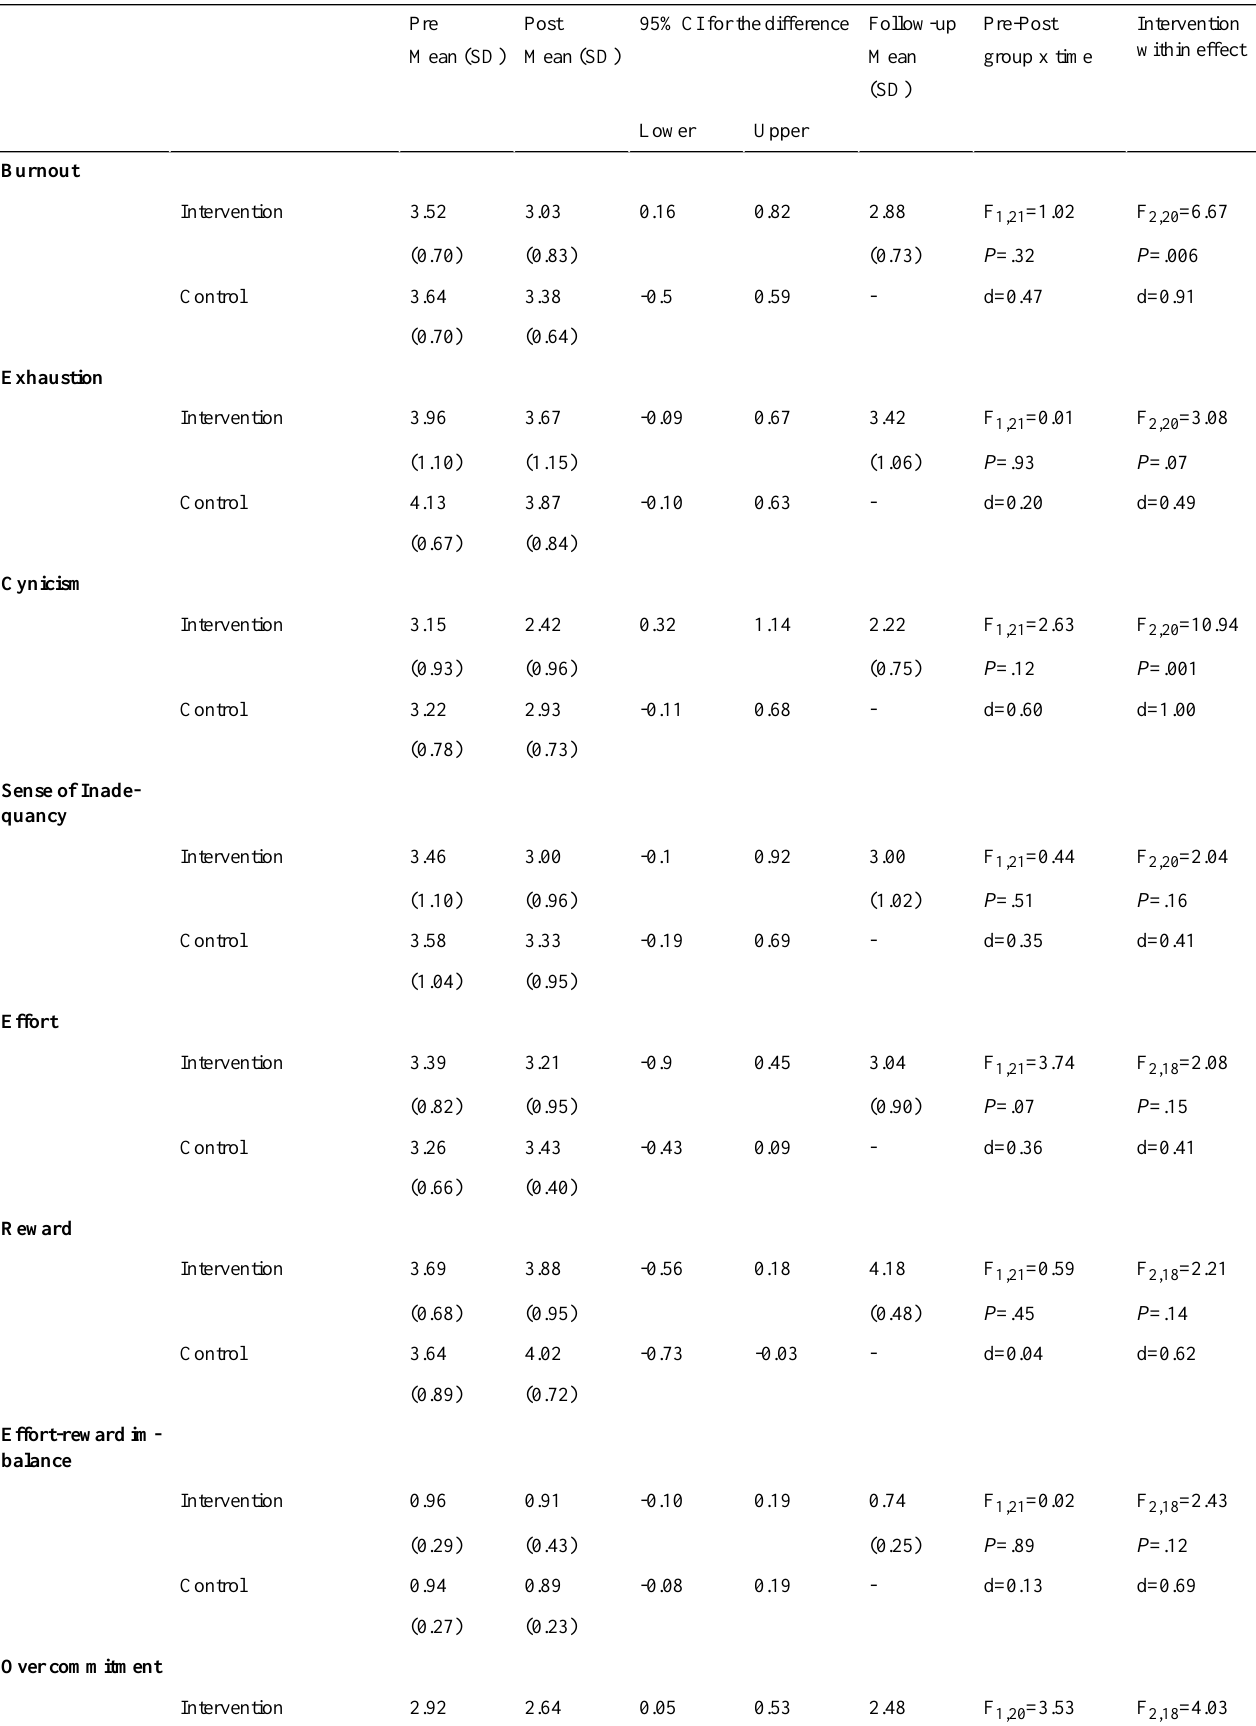
Table 4. Burnout and stress for the intervention and control group.